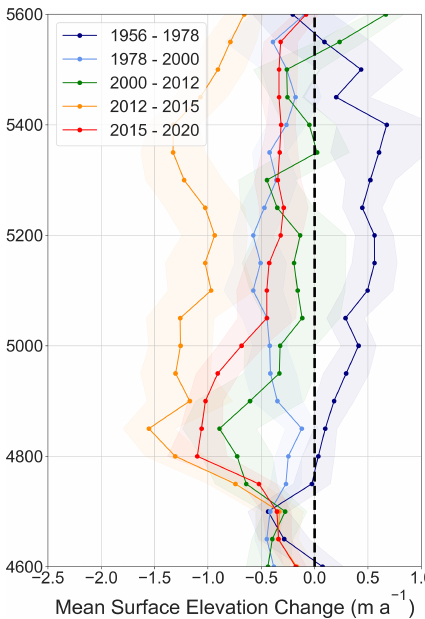
Figure 5. Change in mean surface elevation per year per altitudinal band for the different time periods for Tapado Glacier. Shaded error bars represent the standard deviation at each elevation